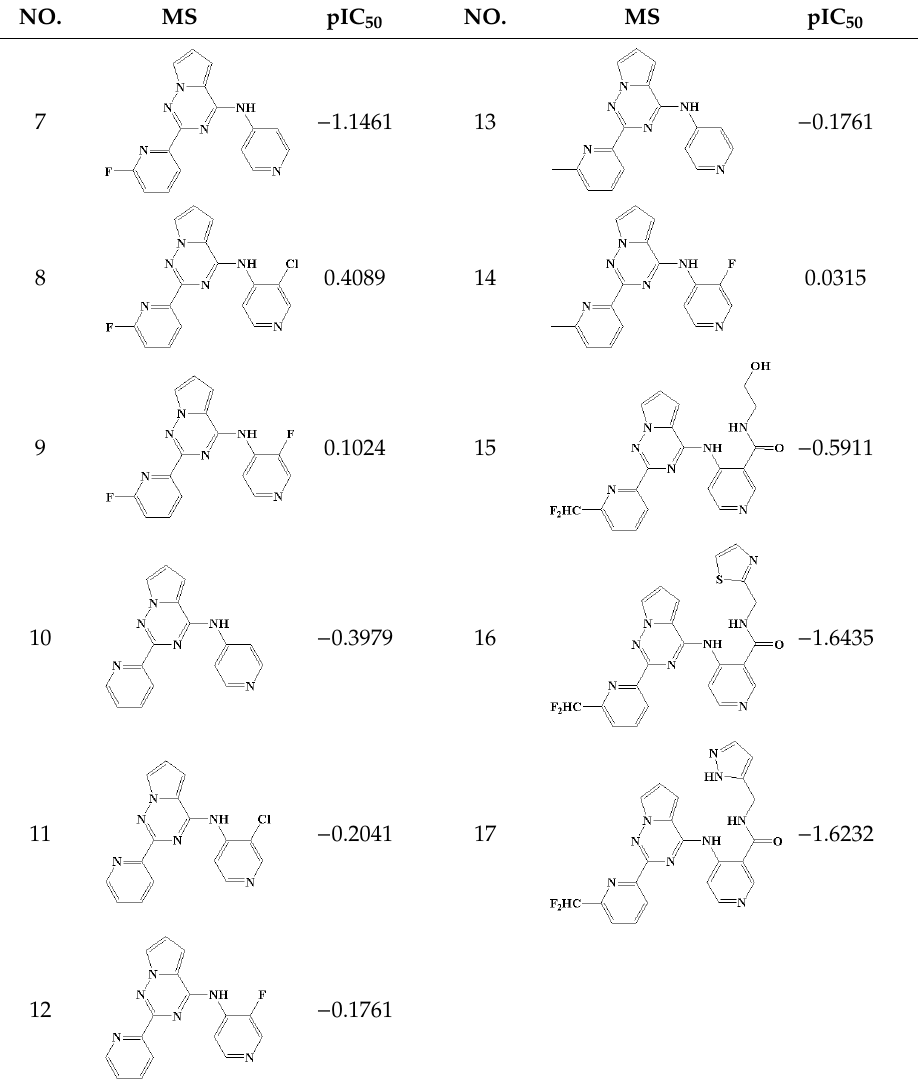
Table 2. The structure-activity relationships in the R2-positon on Ring A. NO.